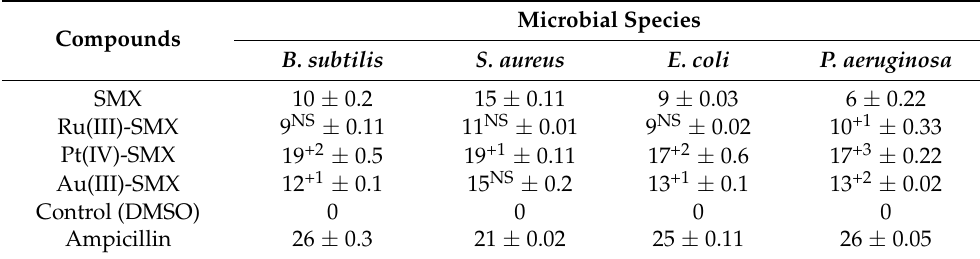
Table 7. Results of antibacterial activity of the prepared complexes.